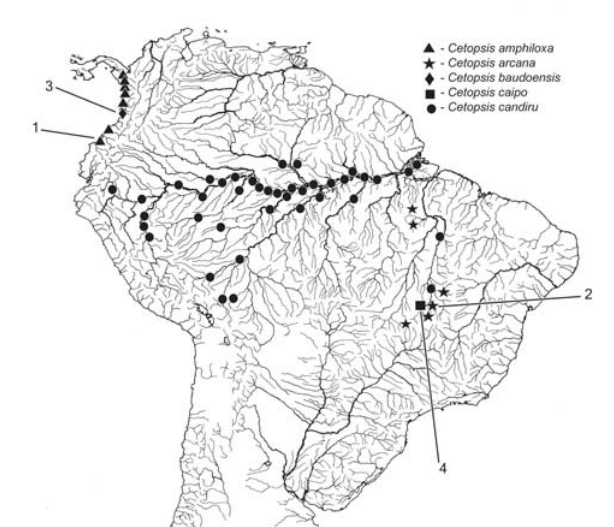
Fig. 12. Map of central and northern South America showing geographic distribution of Cetopsis amphiloxa (1 = holotype locality of Hemicetopsis amphiloxus ), Cetopsis arcana (2 = holotype locality), Cetopsis baudoensis (3 = holotype local- ity of Pseudocetopsis baudoênsis ), Cetopsis caiapo (4 = ho- lotype locality), and Cetopsis candiru (type locality inexact = rivers of Equatorial Brazil) (some symbols represent more that one locality and/or lot of